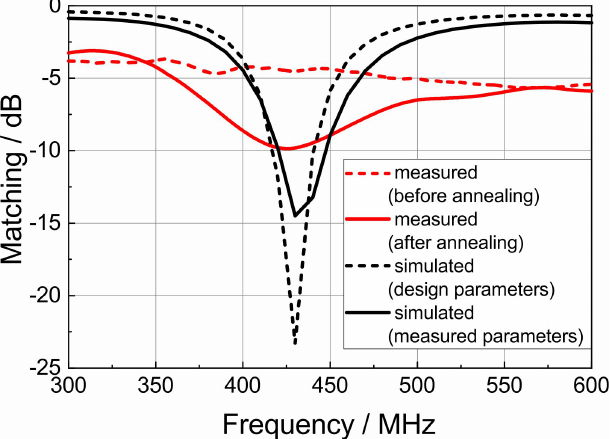
Figure 8. Matching of antenna ( S 11 parameter). Presented are measurements before and after tempering as well as a simulation with parameters used for the design and a simulation with the adjusted parameters according to the achieved values in the